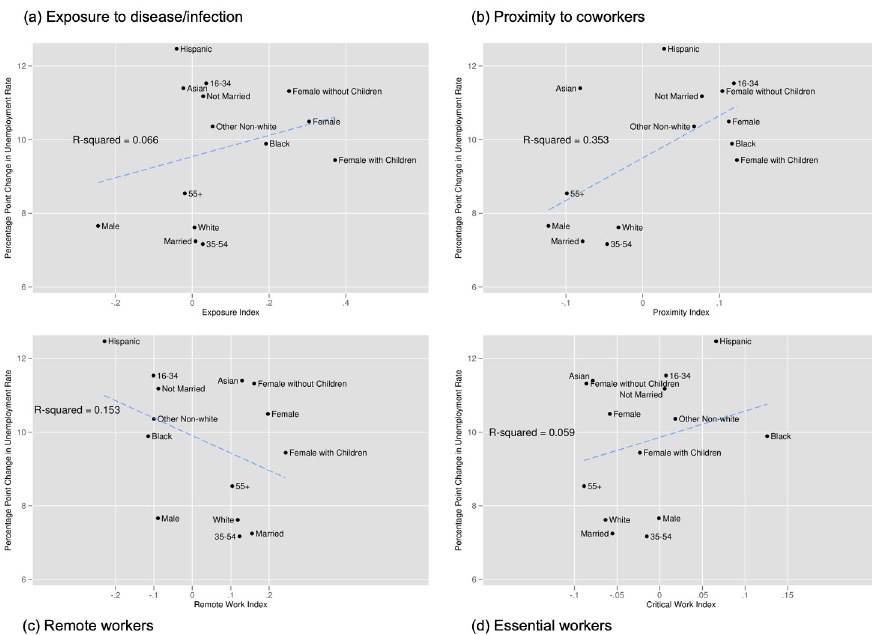
Fig 12. Percentage point change in unemployment (january 2020 to may 2020) by index and demographics. Notes: Unemployment data are from Current Population Survey, indexes are calculated by authors using data from O � NET, LMI, and [1]. The x-axis indicates the index value while the y-axis indicates the change in unemployment rate from January 2020 through May 2020. Each dot is a demographic characteristic. Index values are normalized to mean 0 and standard deviation